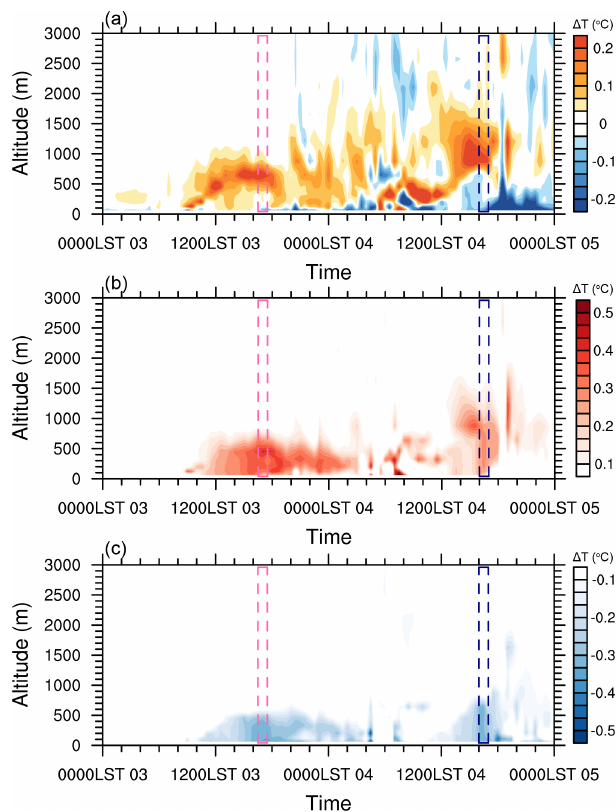
Figure 8. Temporal evolution of temperature profile variation in- fluenced by the aerosol radiative effect (ARE). (a) ARE by all the aerosols (EXP_Ctrl – EXP_WoF). (b) ARE by BC (EXP_Ctrl – EXP_WFexBC). (c) ARE by other aerosols (EXP_WFexBC – EXP_WoF). The pink and blue dashed boxes correspond to the air- craft observation periods on 3 and 4 January,